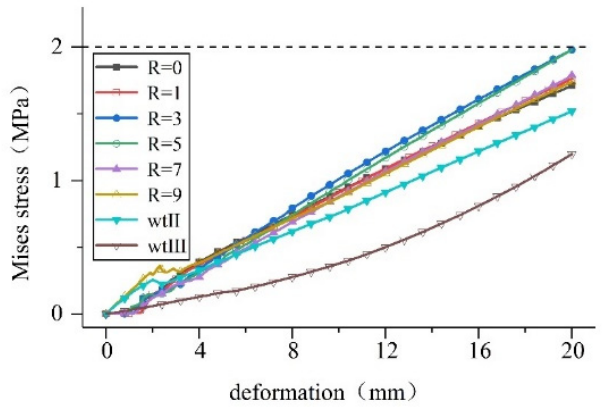
Figure 19. Tensile deformation stress on waterstops of various sizes.